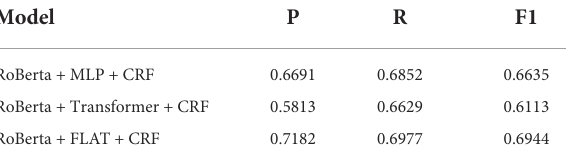
TABLE 2 Results of entity recognition.